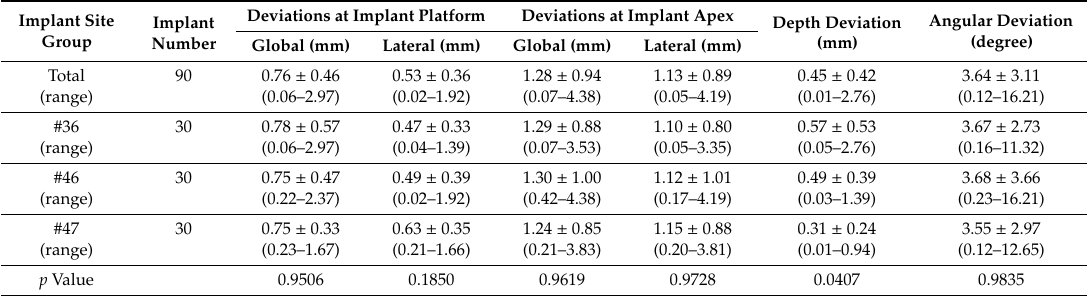
Table 1. Global, lateral, depth, and angular deviations between the planned and placed implant position. Implant Site Group